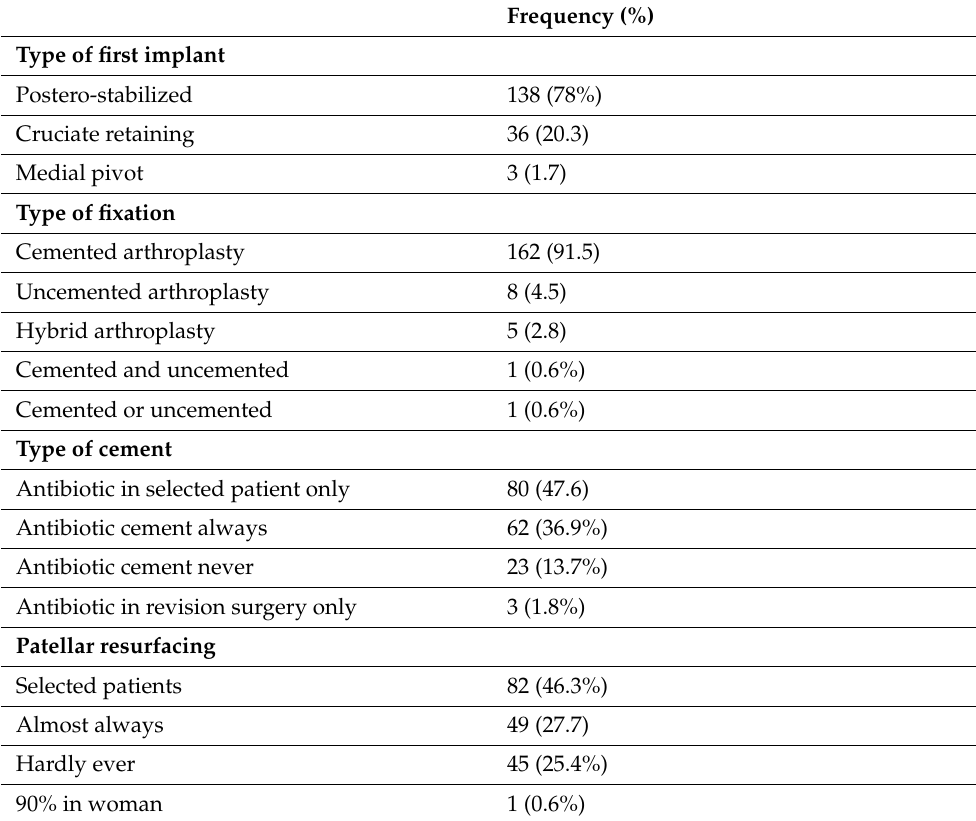
Table 3. Total knee arthroplasty related data.